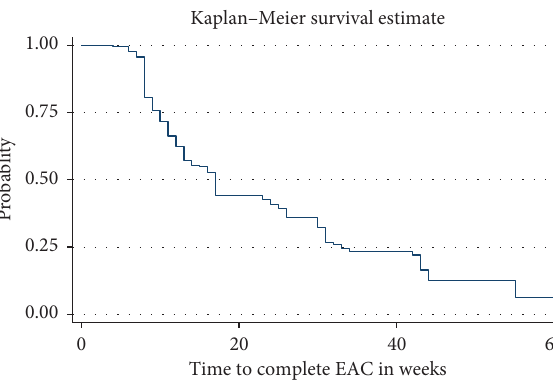
Figure 1: Kaplan–Meier survival curves showing failure experiences of patients who completed